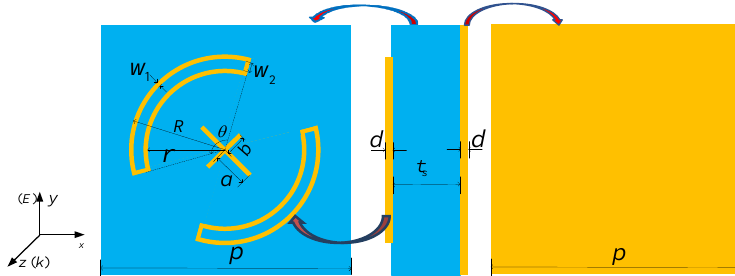
Figure 1. Schematic diagram of the designed linear polarization converter (yellow: metal; blue: dielectric spacer material).